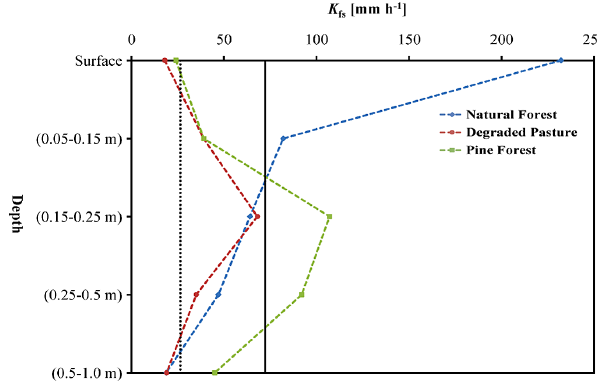
Figure 3. Changes in field-saturated hydraulic conductivity K fs with depth as a function of land use near Dhulikhel, central Nepal. The dotted and solid horizontal lines represent the median and 95 percentile of RI 5max rainfall intensity, respectively (modified after Ghimire et al.,